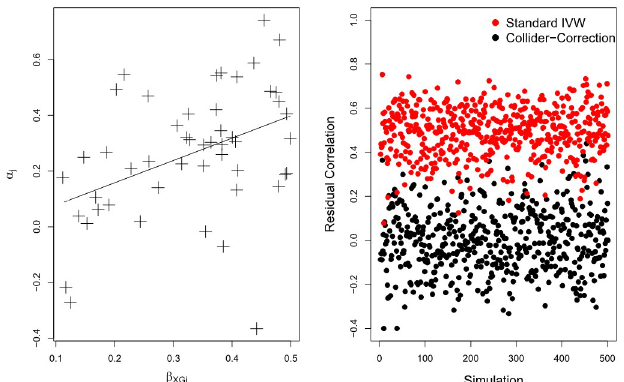
Fig 3. (A = Left): Scatter plot of β between ^ d and ^ y (black) and ^ d j j